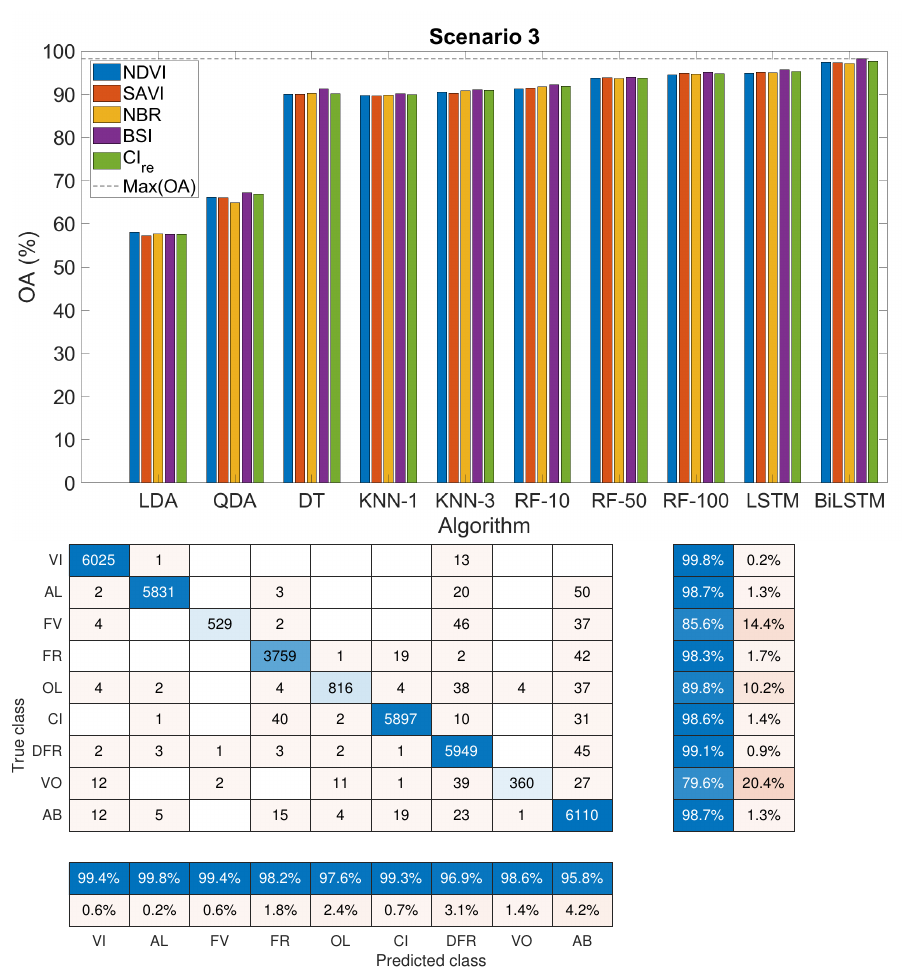
Figure 5. Results for the scenario 2: ( top ), accuracies. ( bottom ), confusion matrix of the best model (2-BiLSTM trained with the BSI dataset).